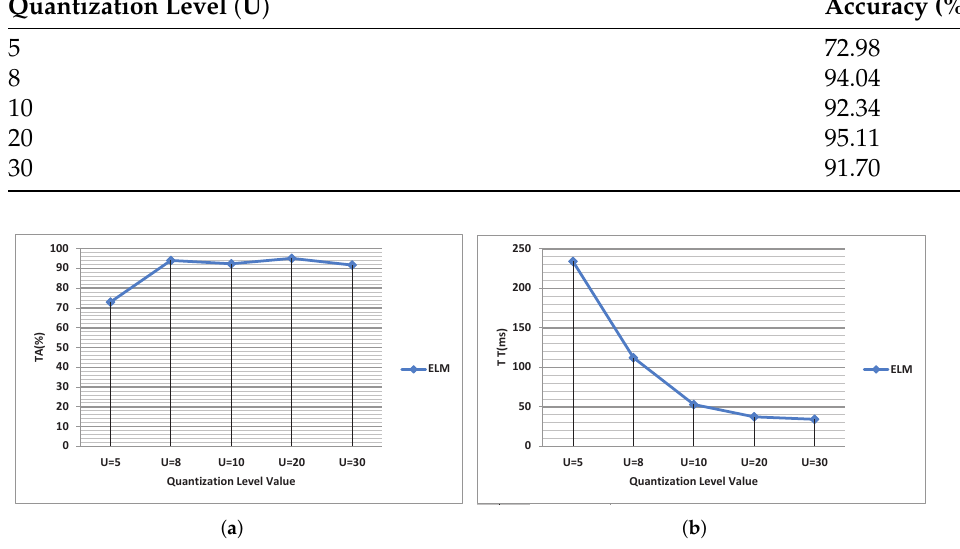
Figure 4. ( a ) TA of the ELM in the case of different quantization levels and ( b ) TT of the ELM in the case of different quantization levels.